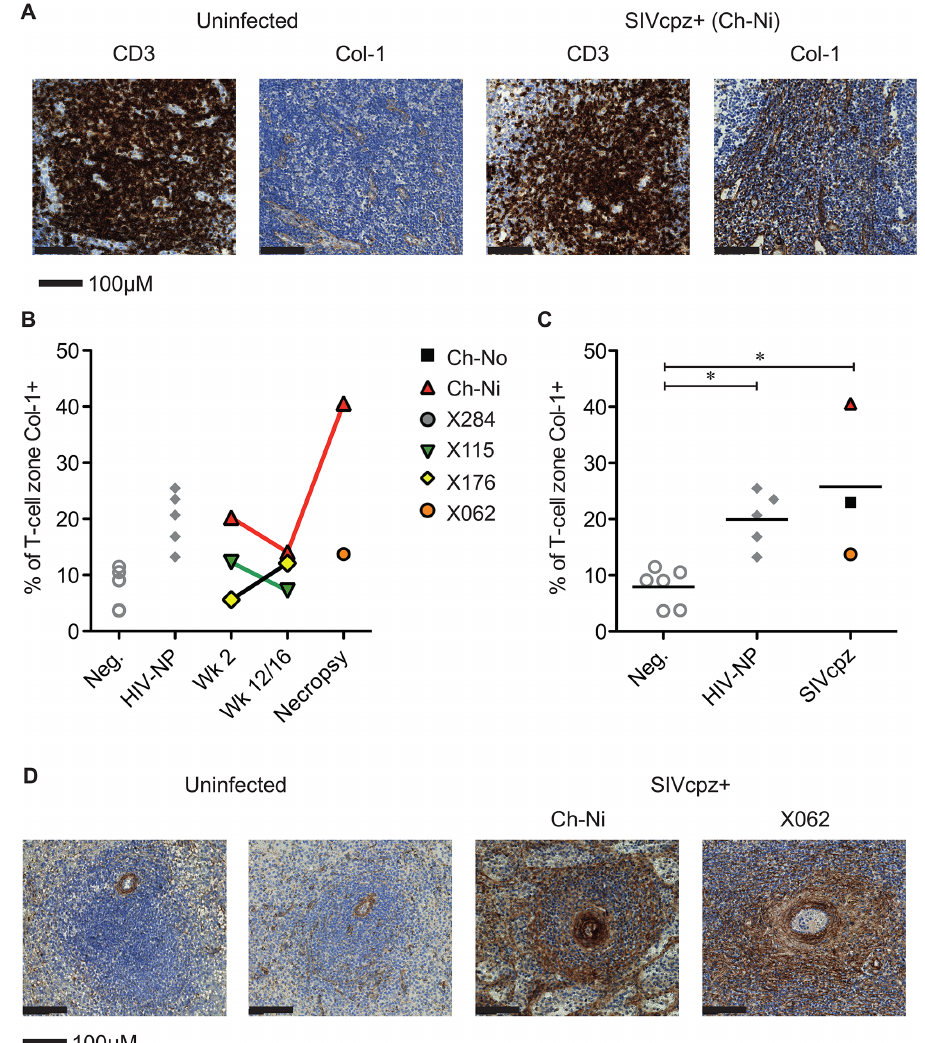
Fig 5. Collagen deposition in SIVcpz infected animals. (A) Representative images of anti- CD3 and anti- collagen 1 immunostainings of lymph nodes from an uninfected chimpanzee and from the chronically SIVcpz infected chimpanzee Ch-Ni. (B) Quantification of collagen I in T-cell zones from experimentally infected animals in early and chronic infection. (C) Comparison of the same parameter in uninfected chimpanzees (n = 6) and chronic HIV-1 (n = 5), and chronic SIVcpz (n = 3) infected chimpanzees. Horizontal black bars indicate the mean value in each group. Group details provided in S7 Table. * indicates P < 0.05 in a Kruskal – Wallis Test with Dunn ’ s post test. (D) Representative images of splenic PALS of two uninfected animals and the two SIVcpz infected animals for which spleen samples were